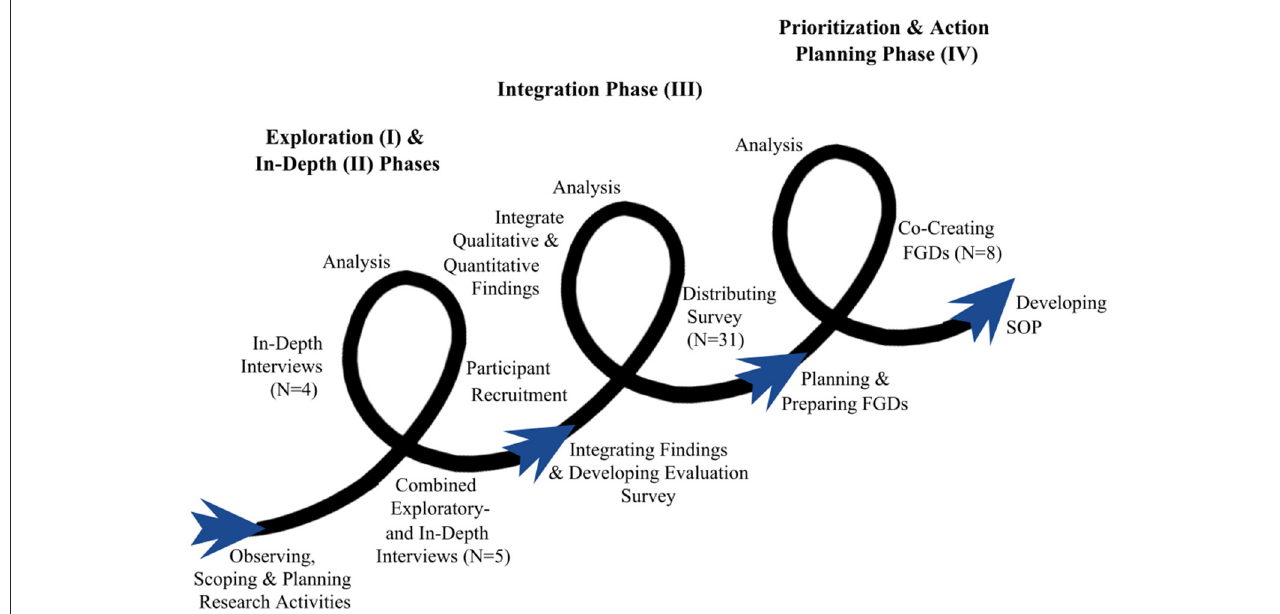
FIGURE1 Learning action spirals of the transdisciplinary approach. Each individual curve indicates the separate phases of the approach. The research activities undertaken are shown around the curves. The spirals point to the feedback loops between the different research activities and show how all activities are interconnected and benefit from each